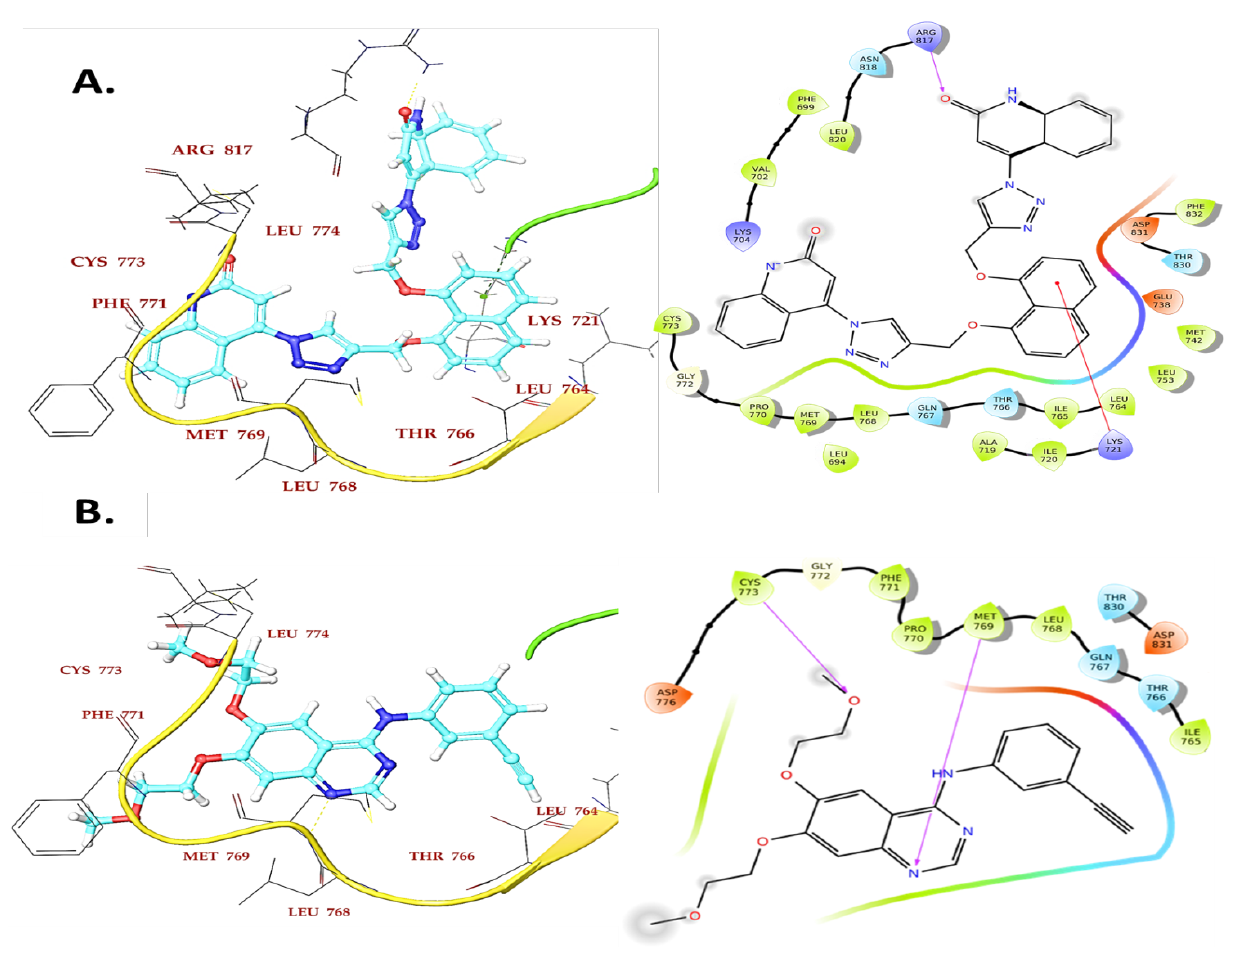
Figure 7. Binding interaction of compound 4a ( A ) and reference compound Erlotinib ( B ) in the ATP binding cavity of EGFR kinase domain.